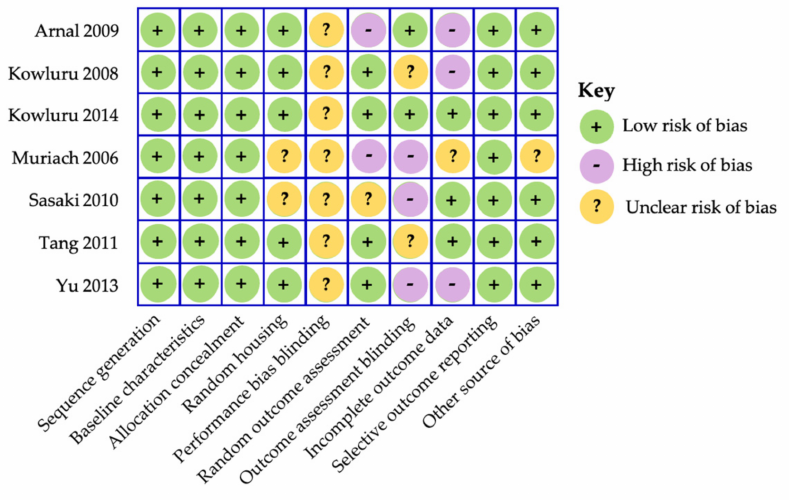
Figure 3. SYRCLE’s risk of bias assessment for animal studies